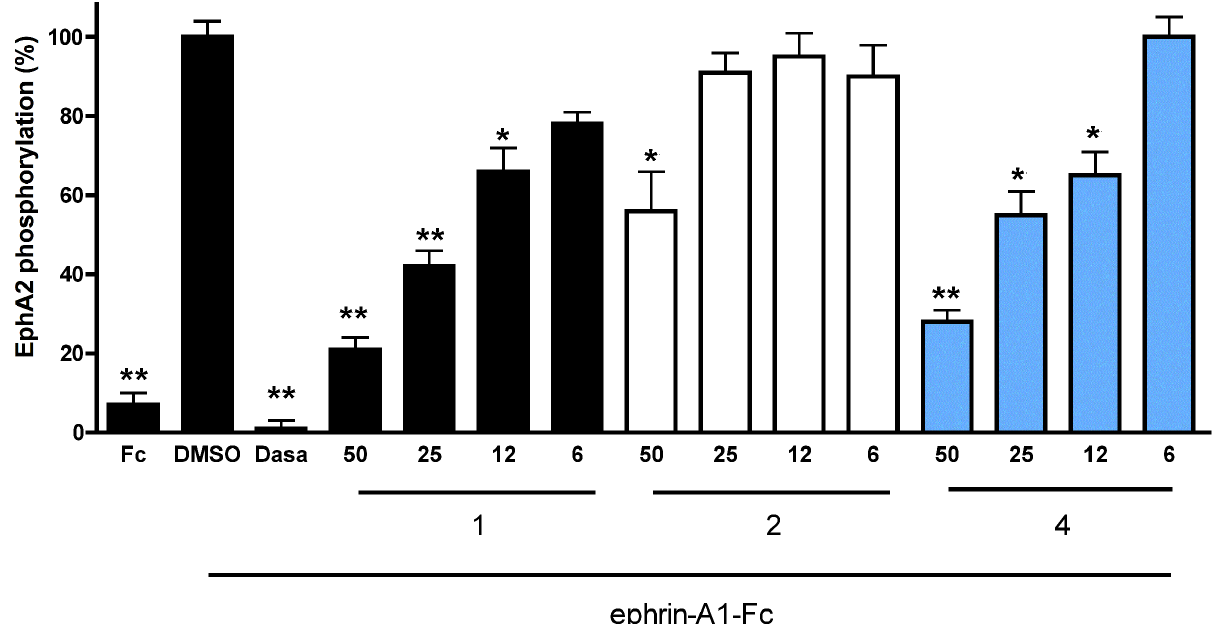
Figure 3. Relative EphA2 phosphorylation in the presence of different concentrations (50 μ M, 25 μ M, 12 μ M, 6 μ M) of compounds 1 (black), 2 (white) and 4 (sky blue). EphA2 phosphorylation was induced by treatment of PC3 cells with 0.25 μ g/mL